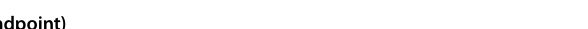
Table 1 Adverse events included in each side effect